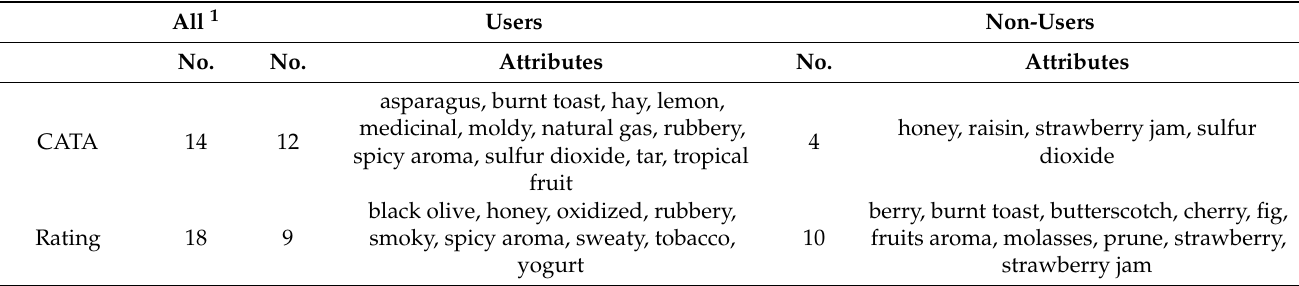
Table 5. Terminology with significant differences between samples using the CATA and rating questionnaires by all consumers, users, and